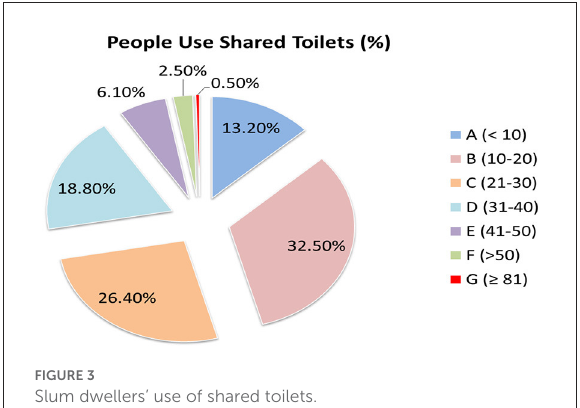
FIGURE3 Slum dwellers’ use of shared